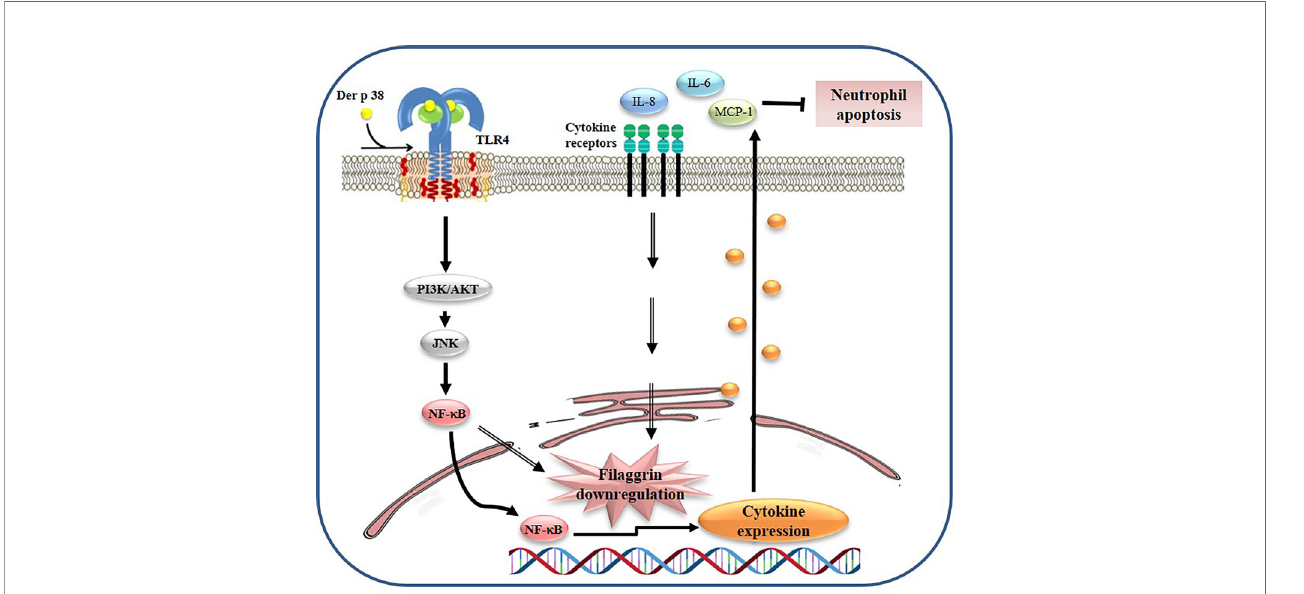
FIGURE 6 | Proposed mechanism of fi laggrin downregulation due to Der p 38 in AD. Der p 38 suppresses fi laggrin expression and induces cytokine release through TLR4, PI3K, AKT, JNK, and NF- k B, which blocks neutrophil